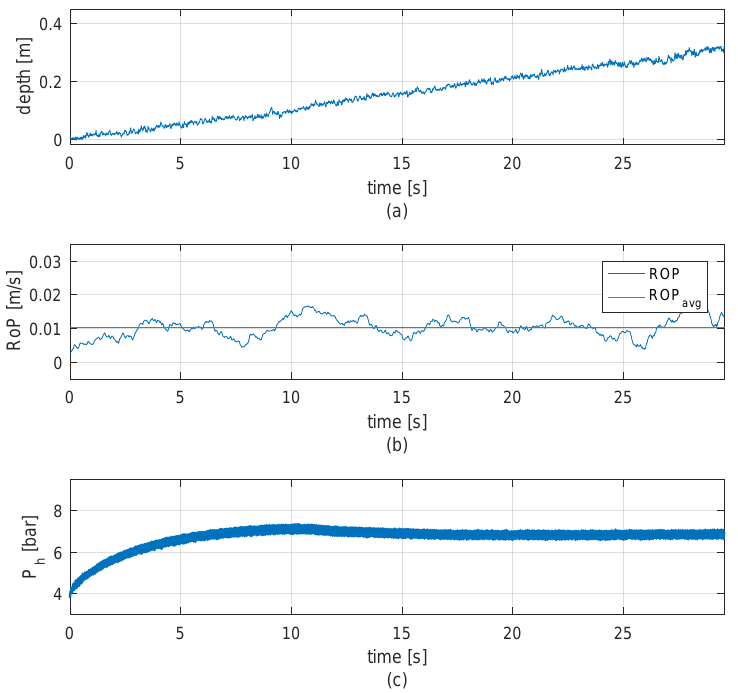
Figure 12. Evaluation of observer-based MWD system during drilling condition of block 2, measured variables: ( a ) depth; ( b ) RoP and average RoP; ( c ) P h